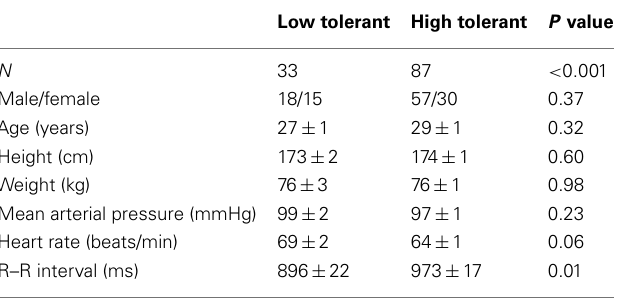
Table 1 | Demographics and baseline hemodynamic variables for low tolerant and high tolerant subjects.